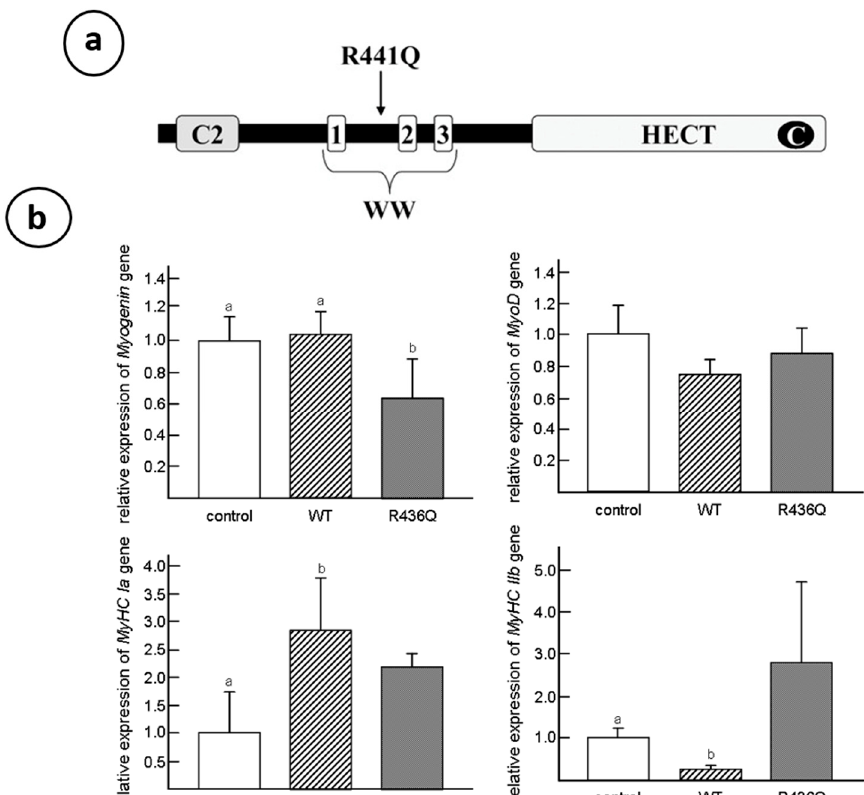
Figure 5. ( a ) The schematic domain structure of chicken WWP1 and the site of missense mutation. Chicken WWP1 protein is composed of 922 amino acids indicating WWP1 functional domains: C2 domain, three WW domains and HECT domain. C in HECT domain indicates an active cysteine residue. The arrow indicates the site of missense mutation. WW domains bind proline-rich region. ( b ) Muscle-differentiation markers ( Myog , MyoD , MyHC Ia and MyHC IIb ) in WWP1 -transfected (WT and R436Q) and empty vector-transfected (control) C 2 C 12 cells. Note that the R436Q-transfected cells retained the high expression of both slow MyHC Ia and fast MyHC IIb isoforms compared to control cells. Y -axis indicates relative expression level of each gene to the GAPDH gene expression. Different letters indicate significantly differences ( p < 0.05) among column graphs. Adopted from Matsumoto et al. 2008 and 2010 [63].